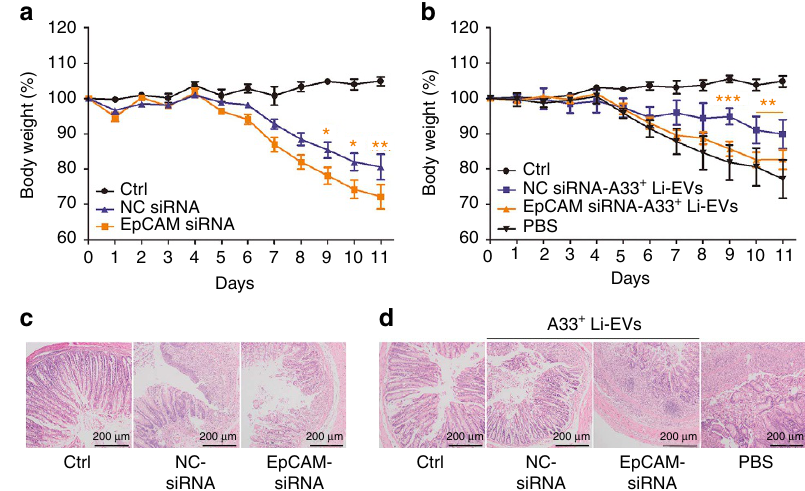
Figure 10 | EpCAM effects on the prevention of murine IBD by A33 þ Li-EVs. ( a ) Mice were fed with 2% DSS solution on day 0 and received intrarectal injection with 20 m g cholesterol-conjugated EpCAM or NC siRNA every other day on days 0–11. The body weights of mice were measured daily. ( b ) Mice with 2% DSS drinking were treated with 100 m g EpCAM siRNA-A33 þ Li-EVs or NC siRNA-A33 þ Li-EVs on days (cid:2) 2 and 2. The body weights of mice were measured daily. ( c , d ) Histological appearance of colon from mice treated as described in a , b on days 11. Representative colonic sections stained with H&E. Ctrl group, mice that received normal drinking water; PBS group, mice with drinking water containing 2% DSS and intravenously treated with PBS on days (cid:2) 2 and 2. Data are presented as the mean ± s.d. from one of the two independent experiments ( n ¼ 5 per group). P values were generated by two-way ANOVA, followed by Newman–Keuls multiple comparison test using GraphPad Prism 5 (* P o 0.05, ** P o 0.01, *** P o 0.001), EpCAM siRNA versus NC siRNA in a and EpCAM siRNA-A33 þ Li-EVs versus NC siRNA-A33 þ Li-EVs in b